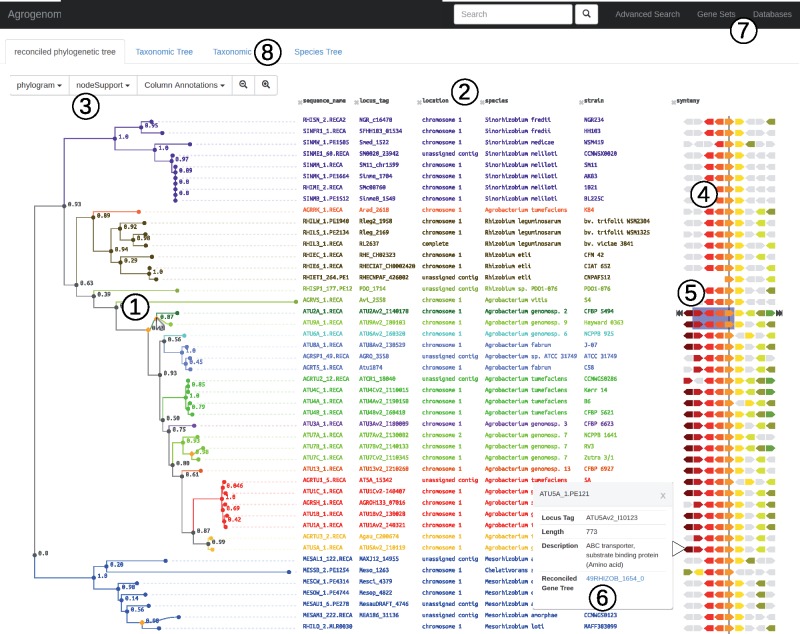
—Snapshot of the Agrogenom web interface. View of the recA gene family. 1) Reconciled gene tree; the orange diamond under the mouse cursor indicates a transfer event from G2-CFBP 5494 to G9-Hayward 0363. 2) Detailed annotation of the sequences at the tip of the tree, including locus tag (linking out to MaGe genome browser), chromosomal location, taxon name, database cross-references, etc. 3) Dynamic menu to adapt the level of displayed information. 4) Syntenic view in the genomic neighborhoods of the focal gene family; homologues share the same color, defined with reference to a chosen sequence (indicated by the navigation arrows on the sides). 5) The blue frame indicates a block transfer event involving four gene families; this block appears dynamically when hovering the cursor above the transfer node in the gene tree. 6) A pop-up window with the functional annotation and characteristics of a gene can be generated by double-clicking on the gene; it contains the link to the gene tree of the gene family. 7) Search menus: rapid search using gene names; “Advanced search” to reach a gene family from its various annotation fields; “Gene Sets” to browse lists of genes: clade-specific genes, core genome, ancestral gene content, clade-specific gains/losses. 8) Alternative views: the reference species tree and a projection of the gene family distribution among taxa.